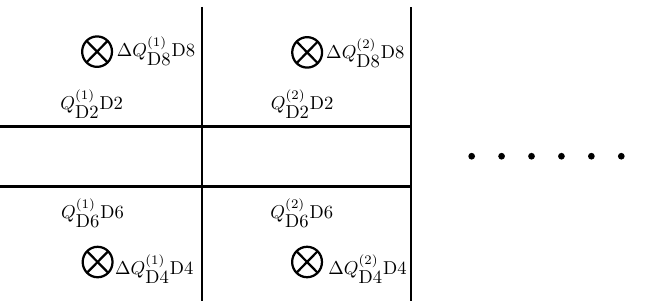
Figure 1. Generic Hanany–Witten brane set-up associated with the holographic background defined by the functions in (6) and (7). The vertical lines are NS5-branes, the horizontal lines represent D2- and D6-branes, and the crosses indicate D4- and